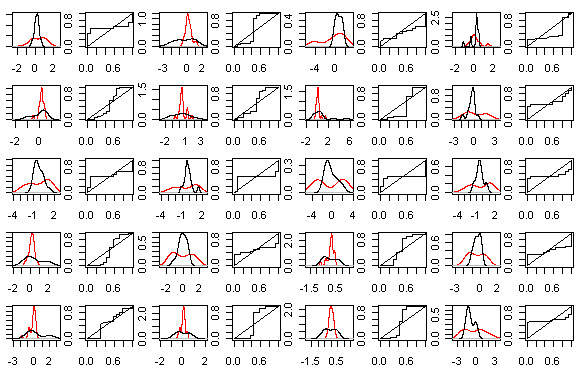
Kernel density plots and empirical ROC plots. Kernel density estimate of the 20 special selected genes expression values, where red densities represent the experimental sample and black densities represent the control sample. The x-axis is on log base 2 scale. From left to the right, each plot pair correspond to densities and respective empirical ROC curve of the gene ID’s: GENE1141X GENE3521X, GENE3547X, GENE3473X, GENE2547X, GENE2519X, GENE1877X, GENE3343X, GENE3322X, GENE3323X, GENE3389X, GENE3388X, GENE3909X, GENE2887X, GENE2778X, GENE463X, GENE1004X, GENE3407X, GENE75X, GENE1817X.